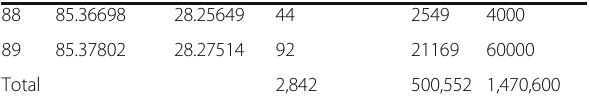
Table 2 Information of damaged along the Pasang Lhamu Highway and associated coseismic landslides (Continued)